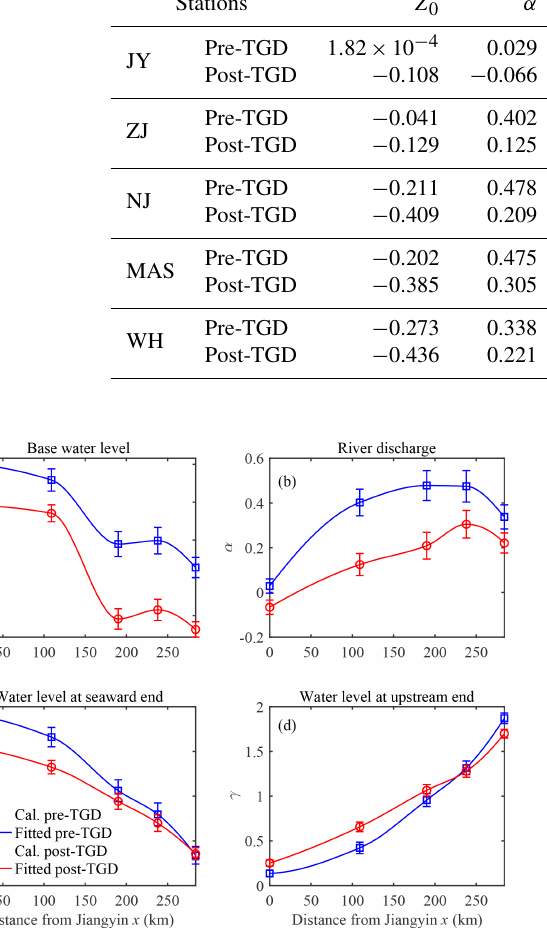
Figure 3. Interpolated linear regression coefficients Z 0 (a) , α (b) , β (c) , and γ (d) with error bar along the upper YRE (upstream of the Jiangyin gauging station) for both the pre-TGD and post-TGD periods. The vertical error bar was estimated using the MATLAB “regress.m” function with 95% confidence intervals.